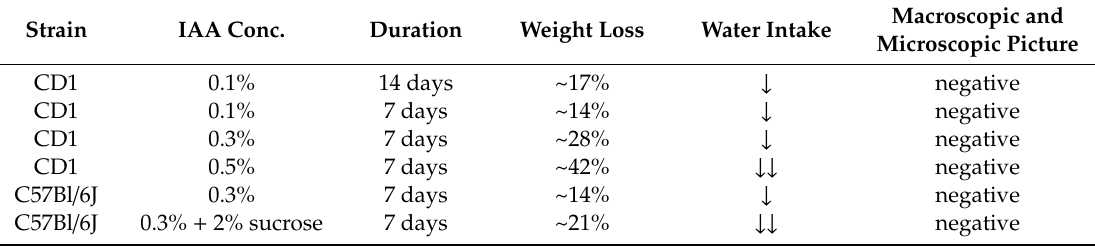
Table 1. Summary of IAA administration-induced alterations in